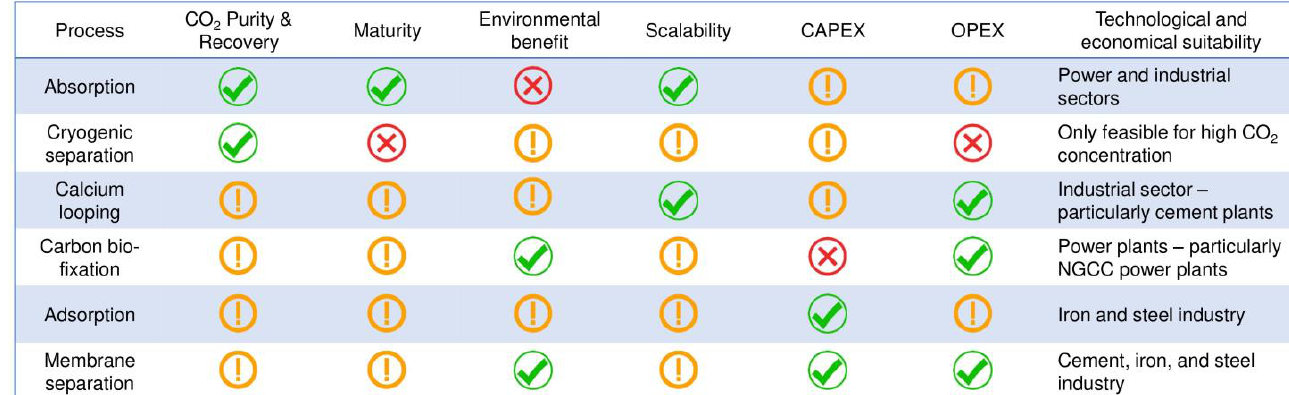
Figure 11. Post-combustion CO 2 capture methods comparison based on five different parameters. This individual comparative assessment is just to identify the relative key highlights of different PCC methods and is not intended to make a final decision. Tick in green, exclamation in yellow, and cross in red marks represent good, neutral, and bad,